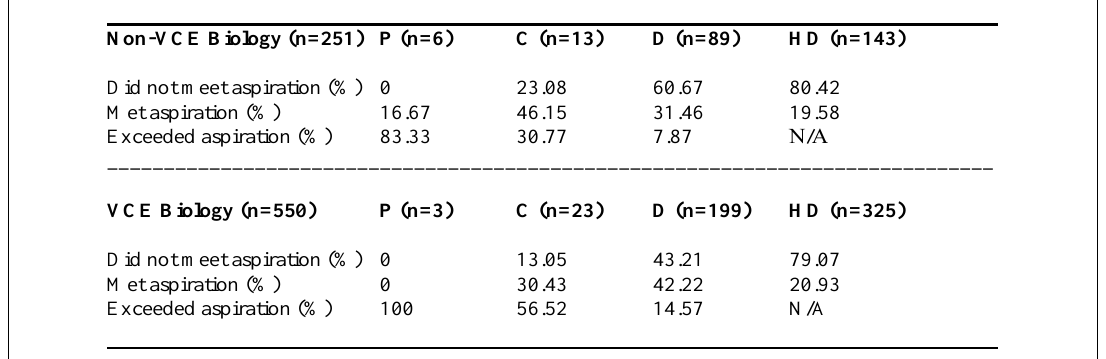
Non-VCE Biology (n=251) P